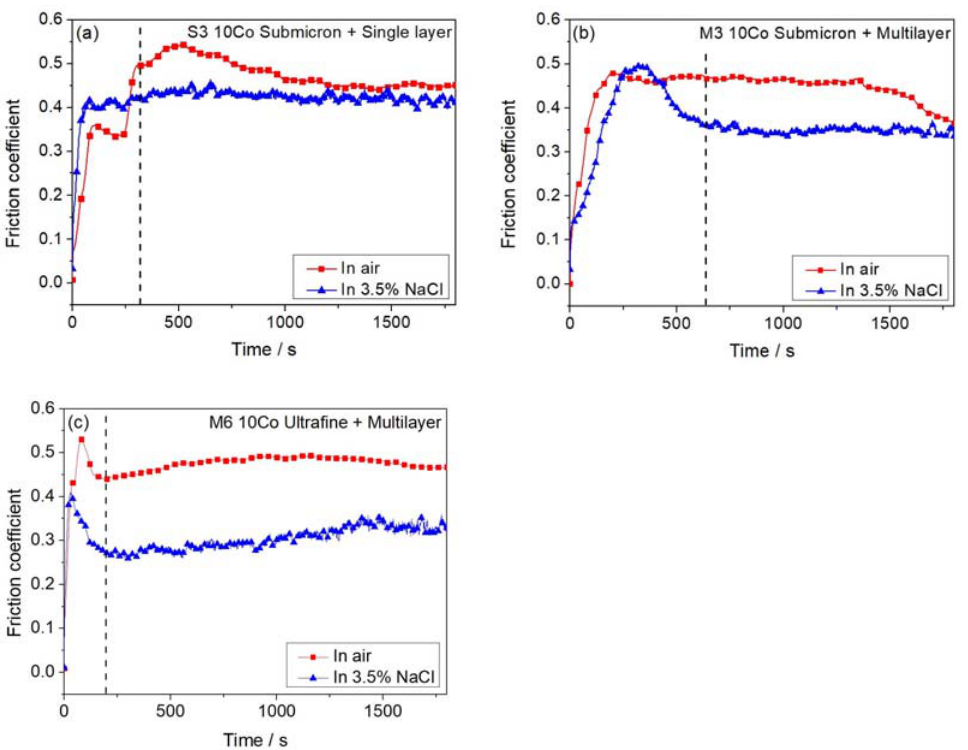
Figure 7. Friction coefficient of typical coated cemented carbides in the air and 3.5% NaCl aqueous solution: ( a ) S3, ( b ) M3, ( c ) M6.